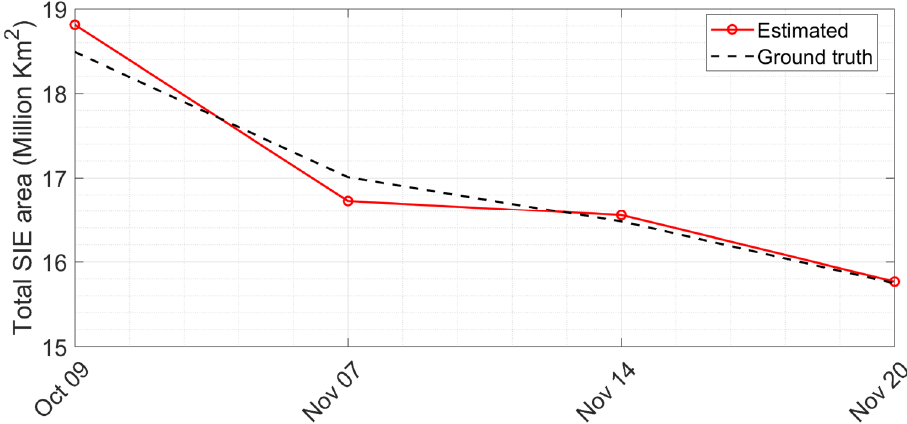
Figure 15. Total Antarctic sea ice extent area.